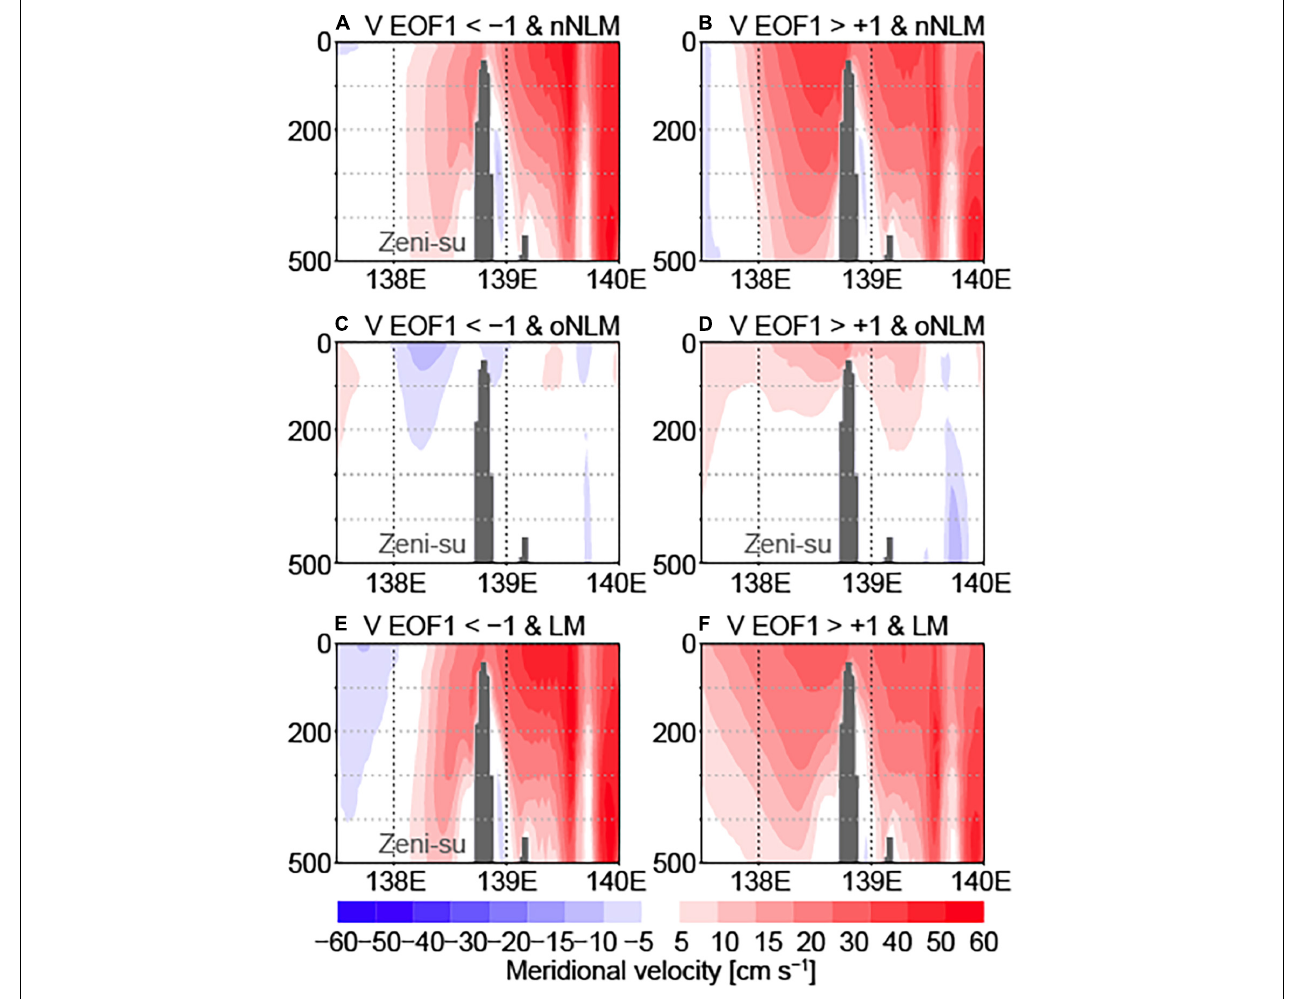
FIGURE 6 | Same as Figure 5 but for meridional velocities on the vertical cross section along 33.95 ◦ N (yellow lines in Figure 5